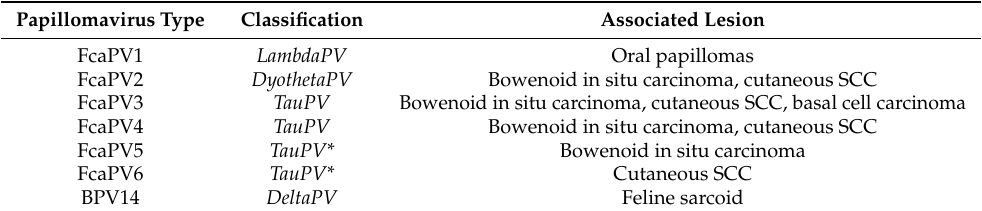
Table 1. Summary of lesions associated with each papillomavirus type known to infect cats. SCC is squamous cell